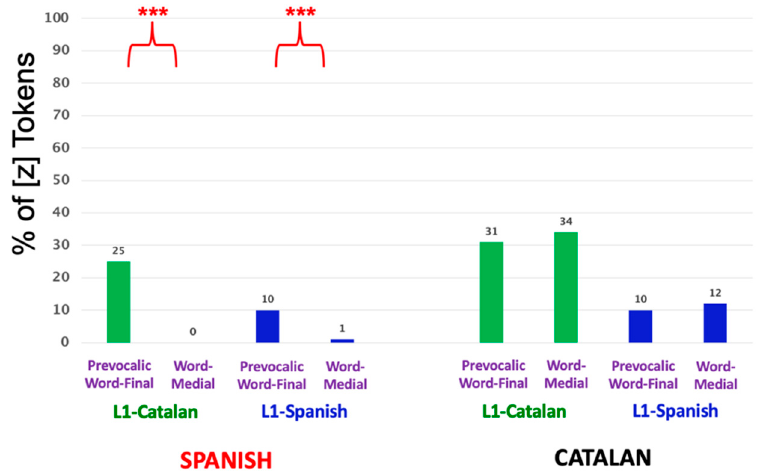
Figure 13. Effect of word position as mediated by language profile and language on Valencian fricative production.